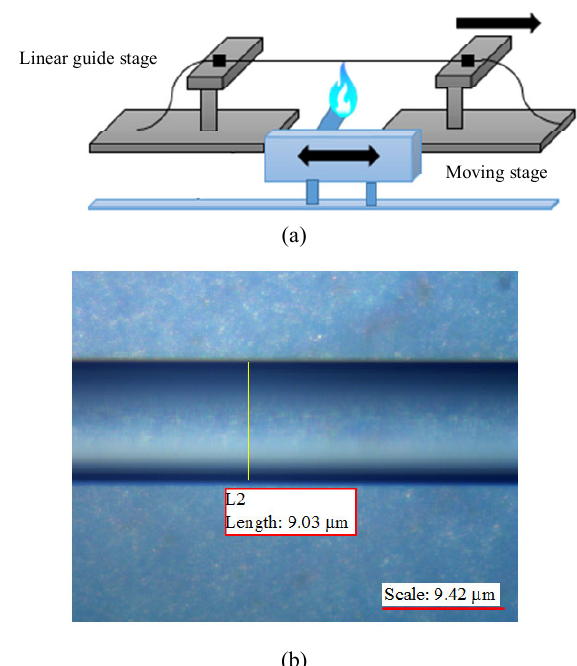
Fig. 2 Figures show (a) the tapering system established in the laboratory and (b) the structure of the tapered SMF observed under the microscope at 100/1.25 resolution with a diameter of 9.03 μ m.